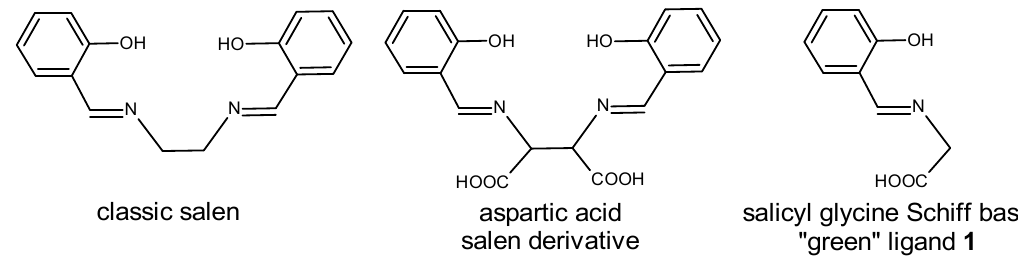
Table 1. Survey of synthesis methods of 1 N -[(2-hydroxyphenyl)methylene]glycine found in the